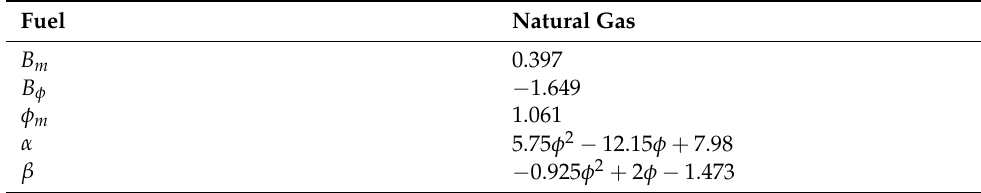
Table 2. The coefficients of natural for calculating the laminar flame